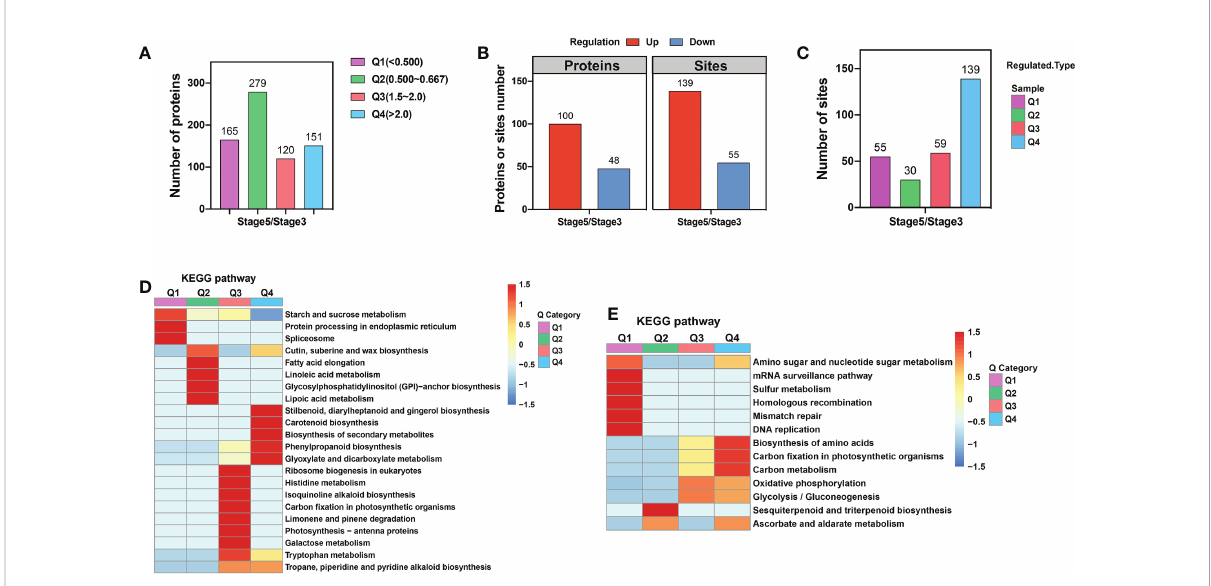
FIGURE 2 KEGG enrichment analysis of proteome and ubiquitome changes in petal AZ identi fi ed through comparison of stages 3 and 5. (A) Numbers of differentially expressed proteins (DEPs). (B) Numbers of proteins or sites showing signi fi cant changes in ubiquitination. (C) The four categories of ubiquitination sites de fi ned based on the ratio of stage 5 to stage 3. Q1 represents ratios of <0.667, Q2 represents ratios of 0.667 – 0.769, Q3 represents ratios of 1.3 – 1.5, and Q4 represents ratios >1.5. (D) KEGG enrichment analysis of proteins with signi fi cantly altered abundance. (E) KEGG enrichment analysis of sites showing signi fi cant changes in